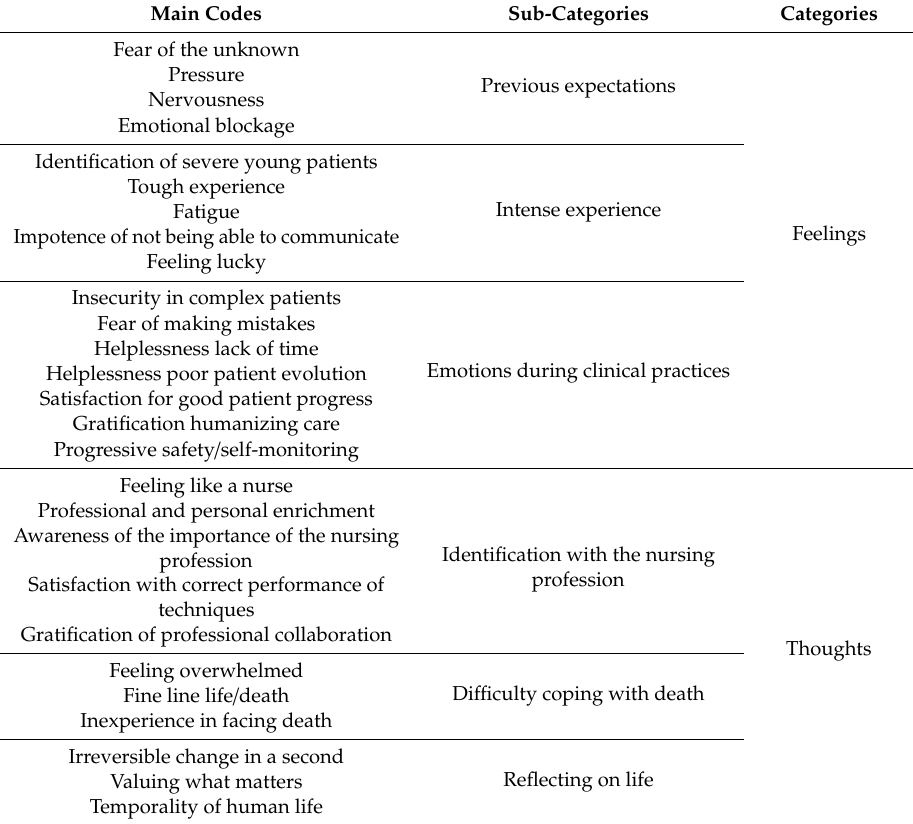
Table 1. Main categories, sub-categories and codes about the theme “intense emotional experience”.